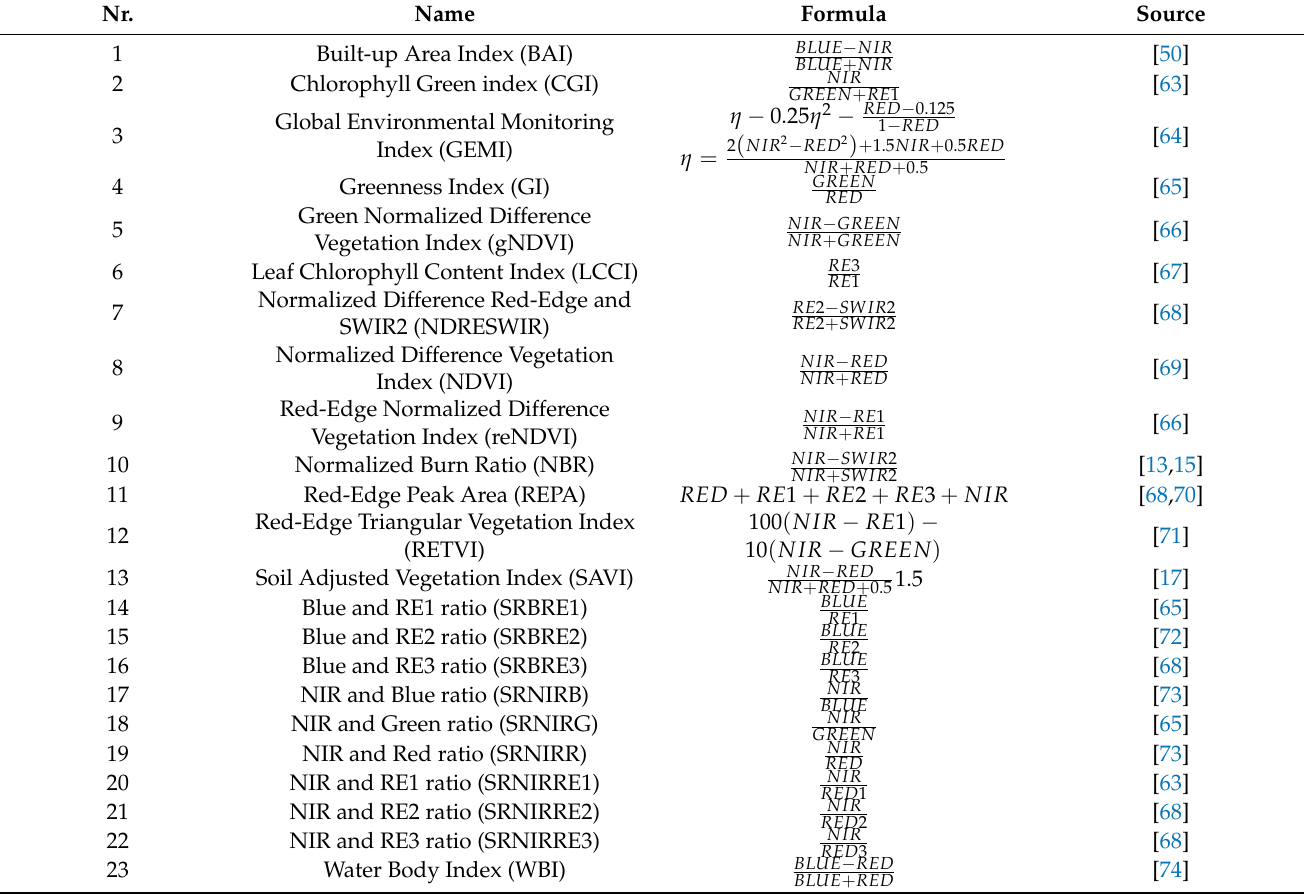
Table A1. Formulas used for the calculation of the vegetation indices using Sentinel-2 scenes from the wildfire area in